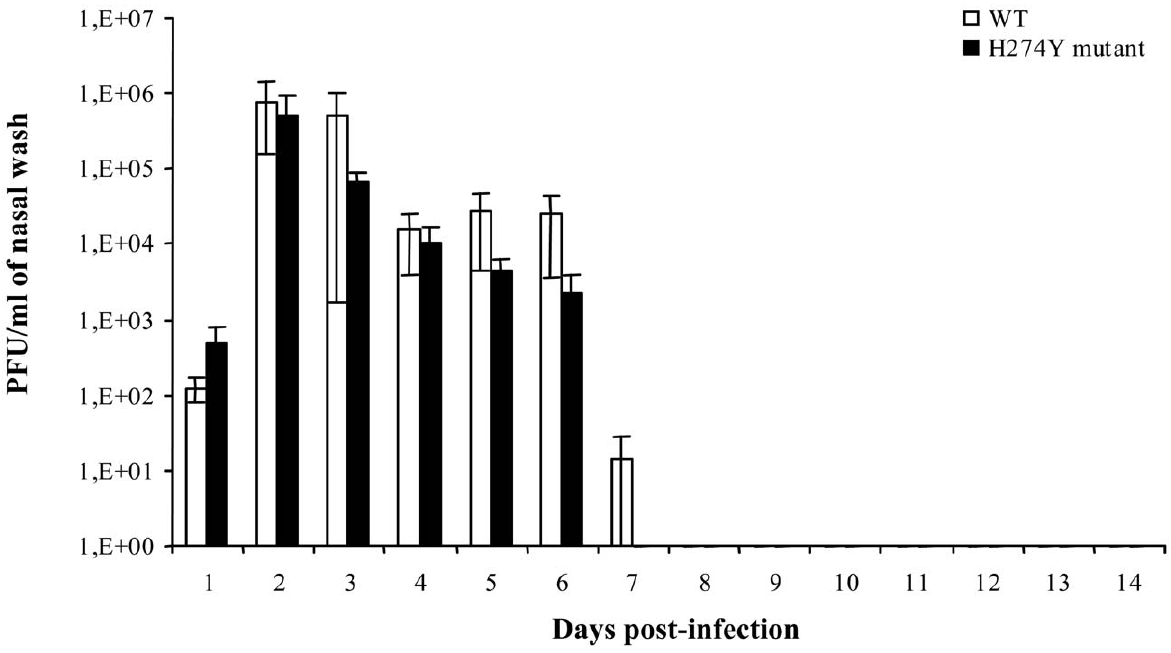
Figure 7. Nasal wash viral titers of ferrets infected with wild-type (WT) or H274Y mutant isolates of pH1N1. Viral titers were determined daily over 14 days post-inoculation from nasal washes of ferrets infected with WT (A/Que´bec/147023/2009) or oseltamivir-resistant H274Y mutant (A/ Que´bec/147365/2009) pH1N1 isolates. Mean viral titers 6 SD from triplicate experiments were determined by using standard plaque assays.